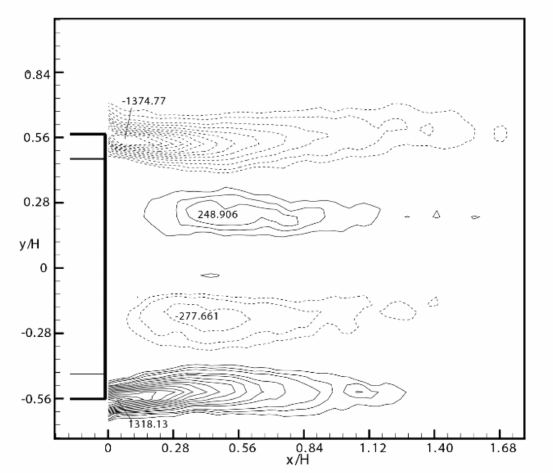
Figure 26. Iso-contours of time-averaged streamwise vorticity, ω z in the x–y plane at z/H = − 0.08. Minimum and incremental values of vorticity are ω z,min = − 119.654 s − 1 , 132.170 s − 1 , and − 1 , ∆ ω z = 96.175 s